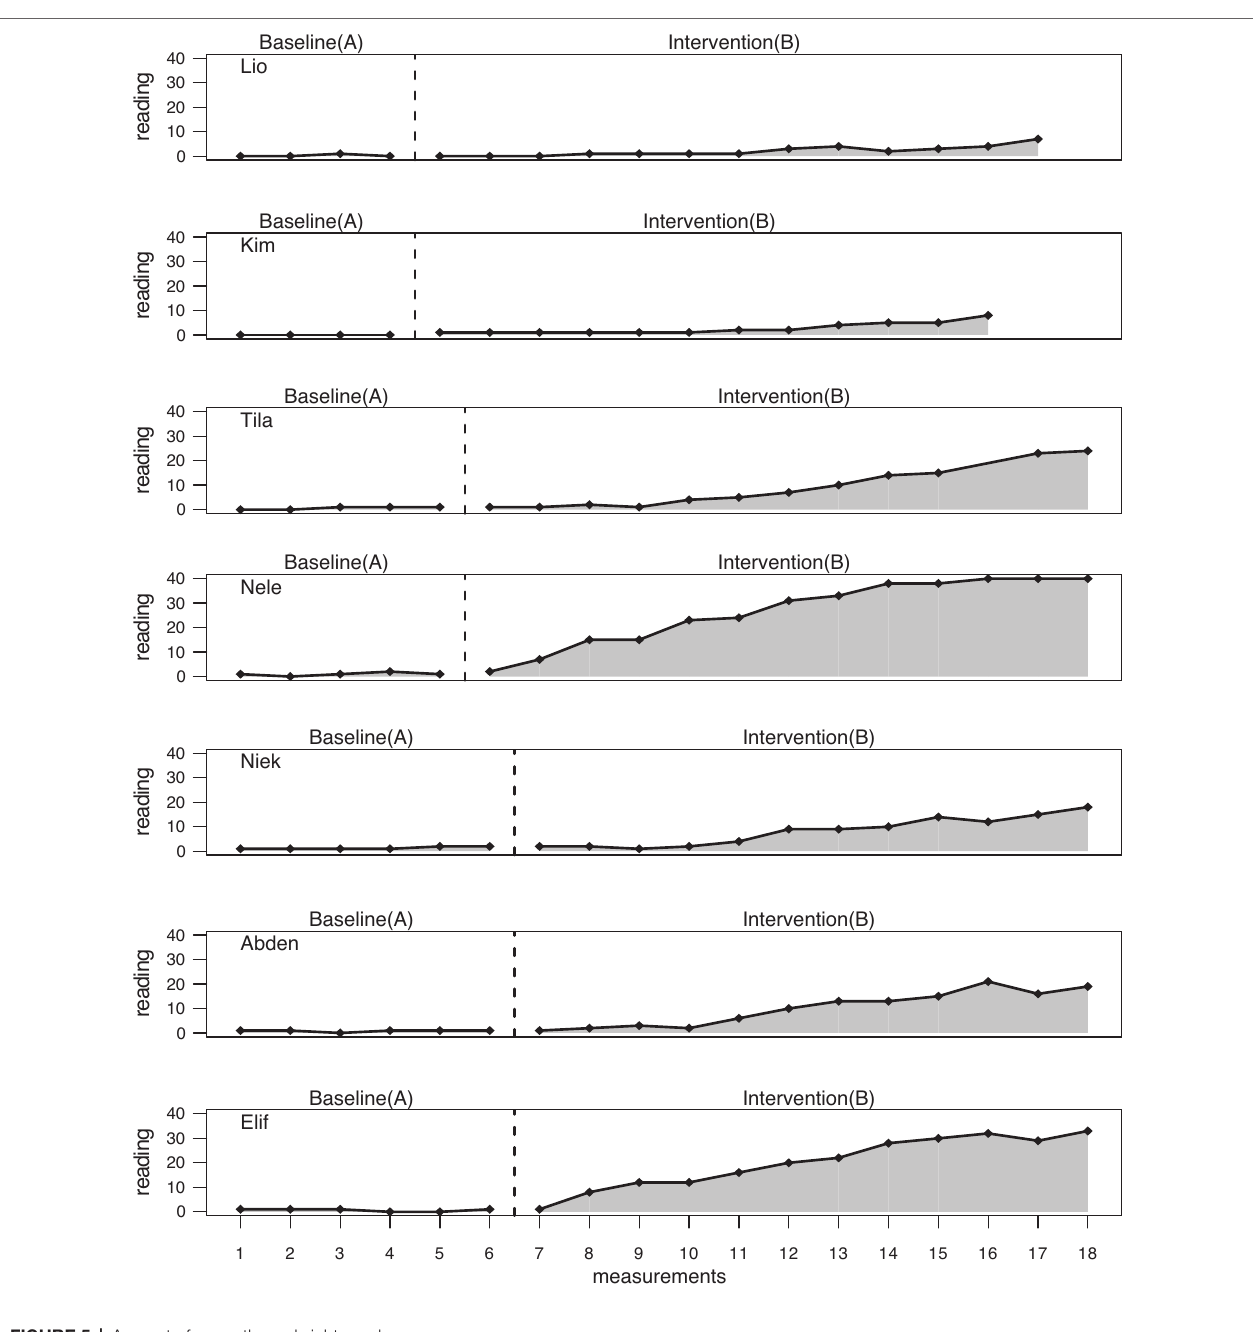
FIGURE 5 | Amount of correctly read sight